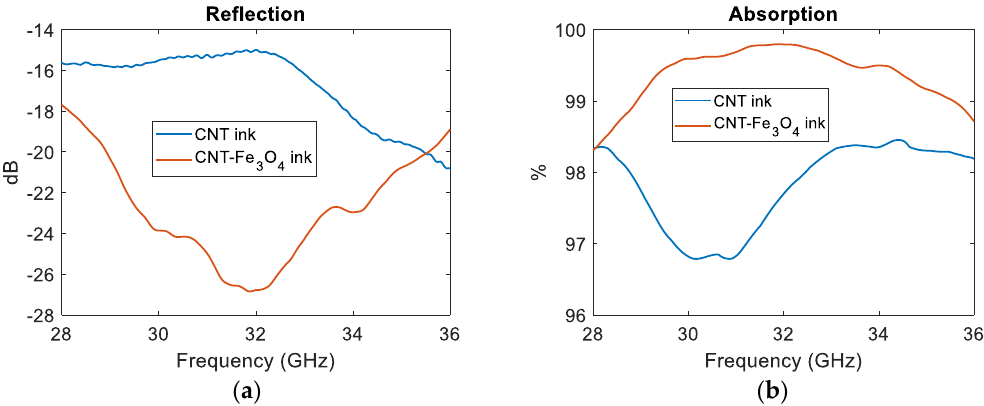
Figure 20. Comparison of performances for MWCNTs-only and Fe 3 O 4 @MWCNTs- ink-printed